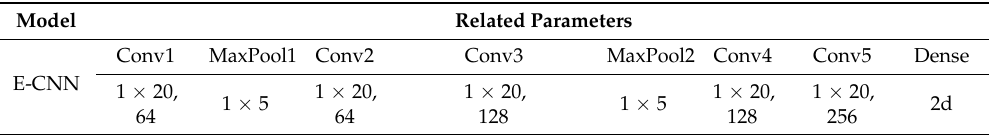
Figure 7. The architecture of convolution neural network E-CNN. Table 3. The parameter of model